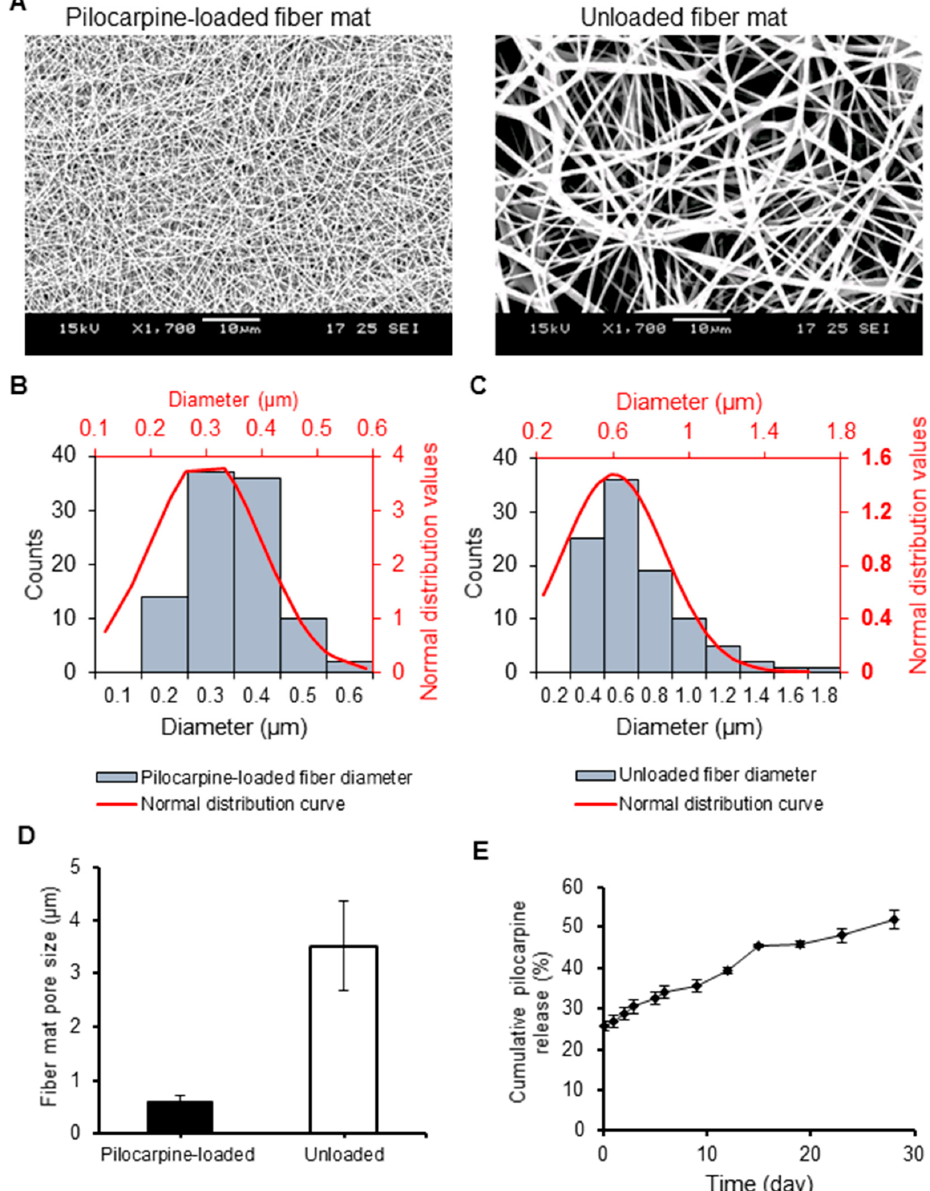
Figure 1. Structural and morphological comparison of pilocarpine-loaded and unloaded PLGA nanofiber mats, and in vitro pilocarpine release profile from pilocarpine-loaded mats. ( A ) Scanning electron microscopy (SEM) images at 1700× magnification. ( B–C ) Diameter distribution of the loaded